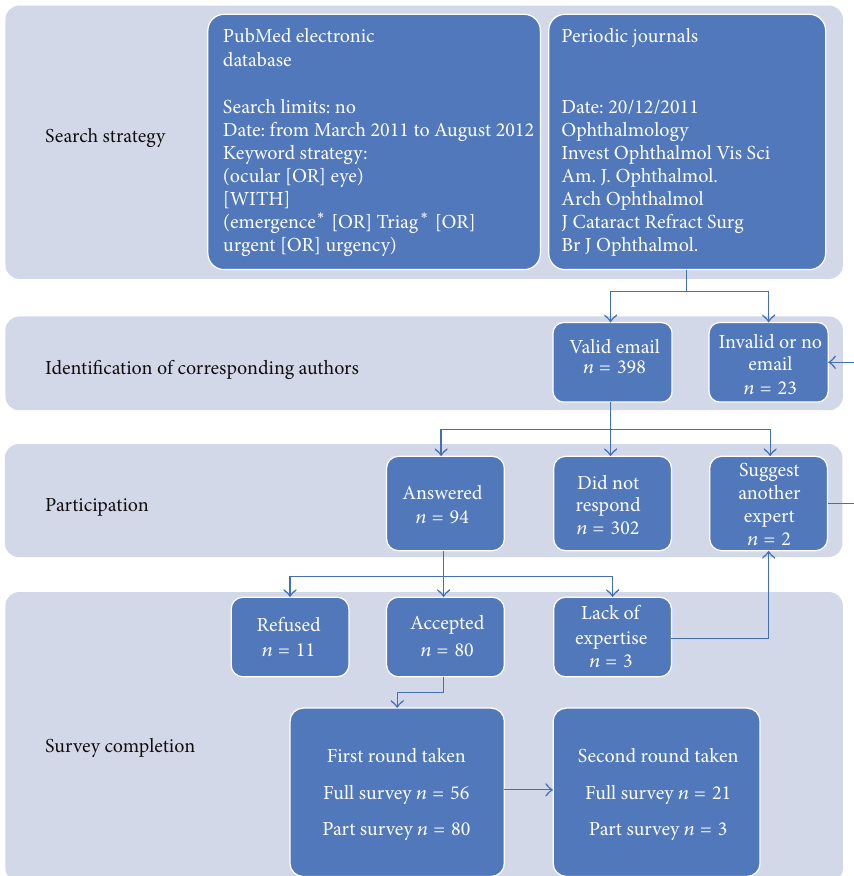
Figure 1: Flow chart of the Delphi process for the BaSe